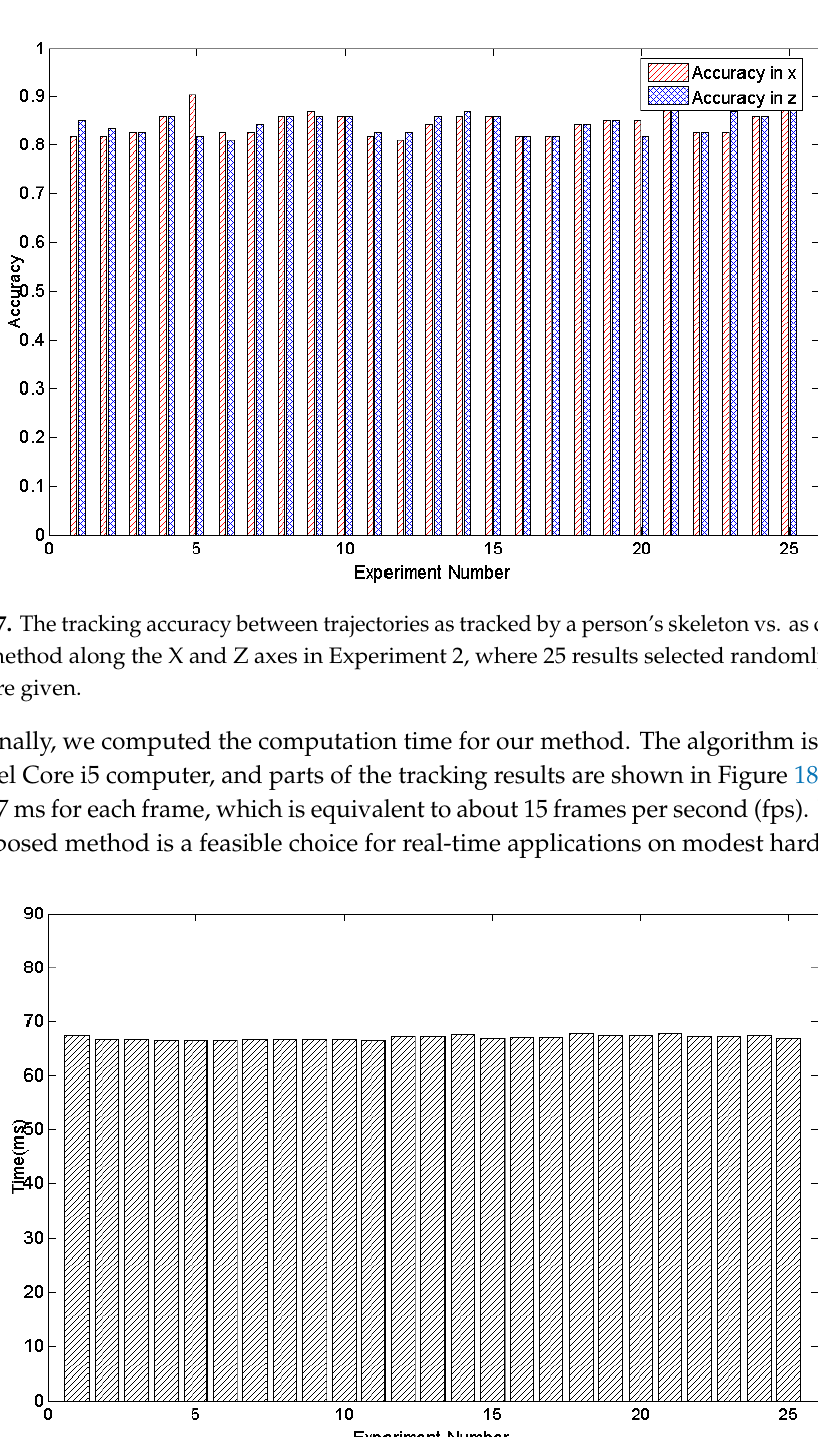
Figure 17. The time cost of 25 times by 5 users for an experimental task.